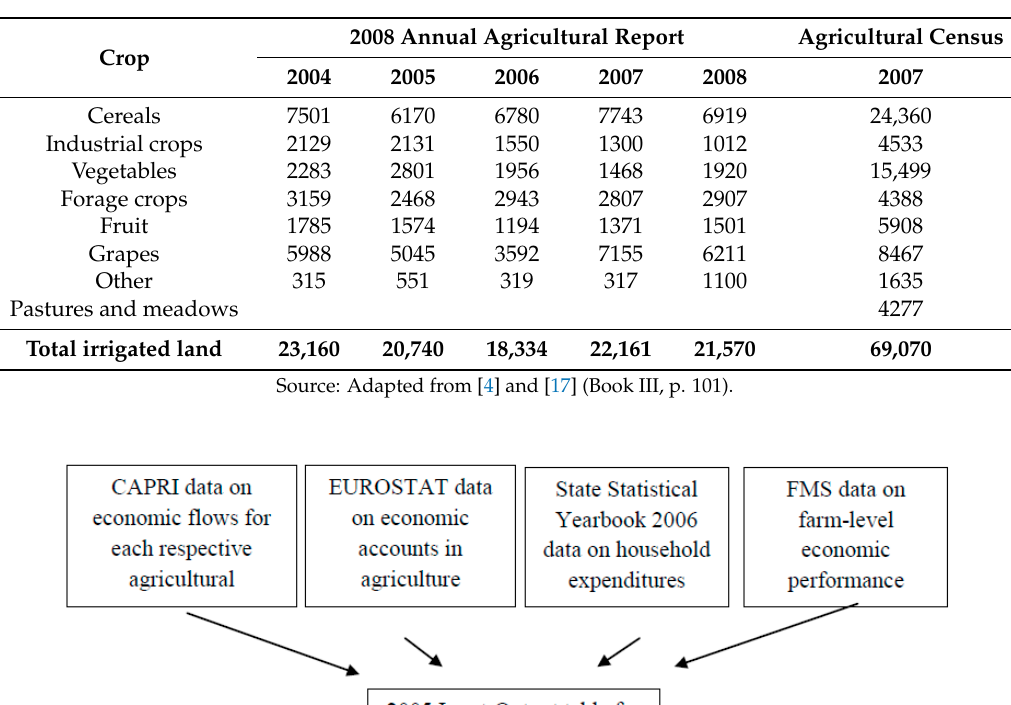
Table 1. Area (ha) of irrigated crop land in Macedonia, according to two reports.